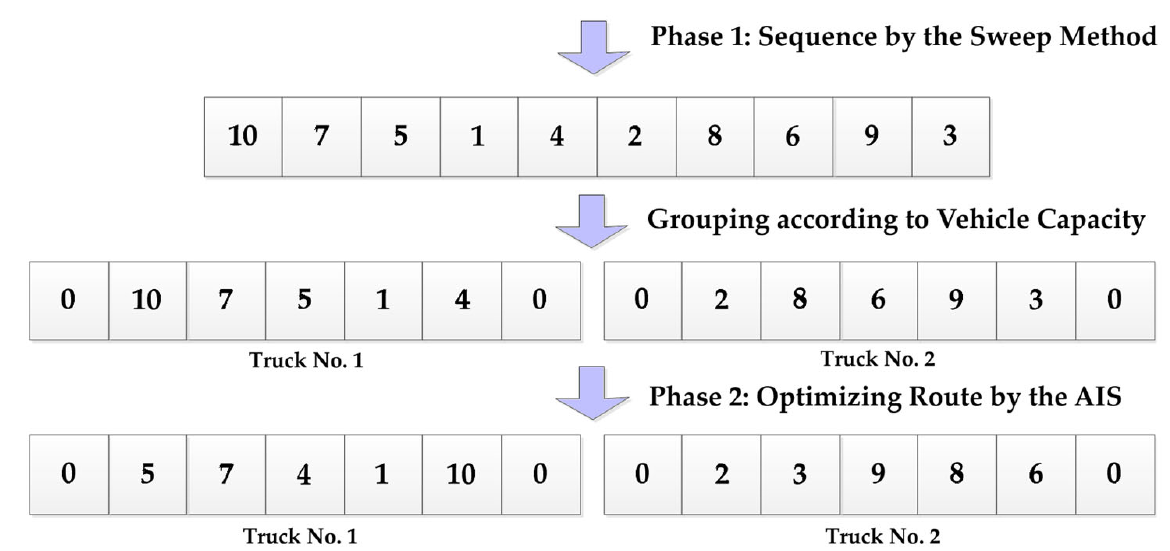
Figure 5. An illustration of 10 nodes with homogeneous demand served by 2 vehicles.